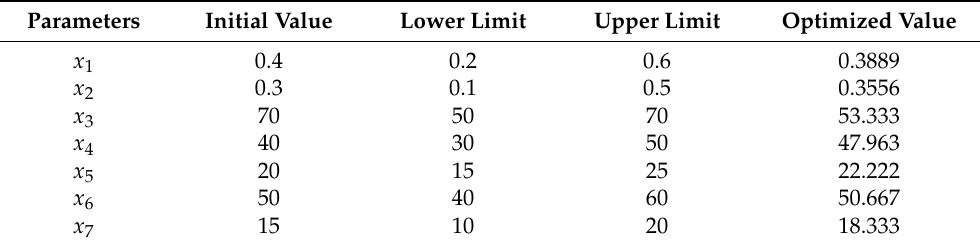
Table 12. Optimized result of key parameters based on DIRECT algorithm.